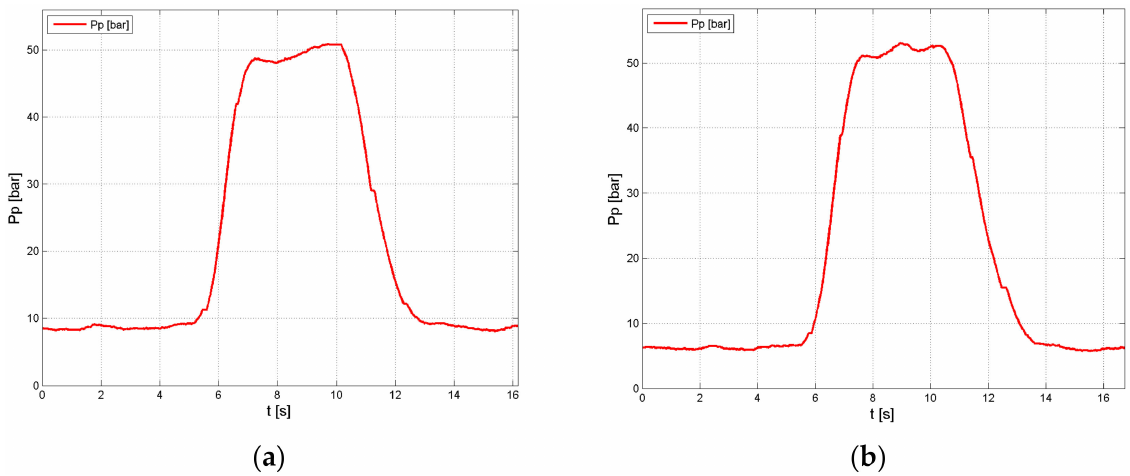
Figure 17. Waveforms of the pressure (Pp) for the speed of: ( a ) 1000 rpm; ( b ) 1500 rpm.